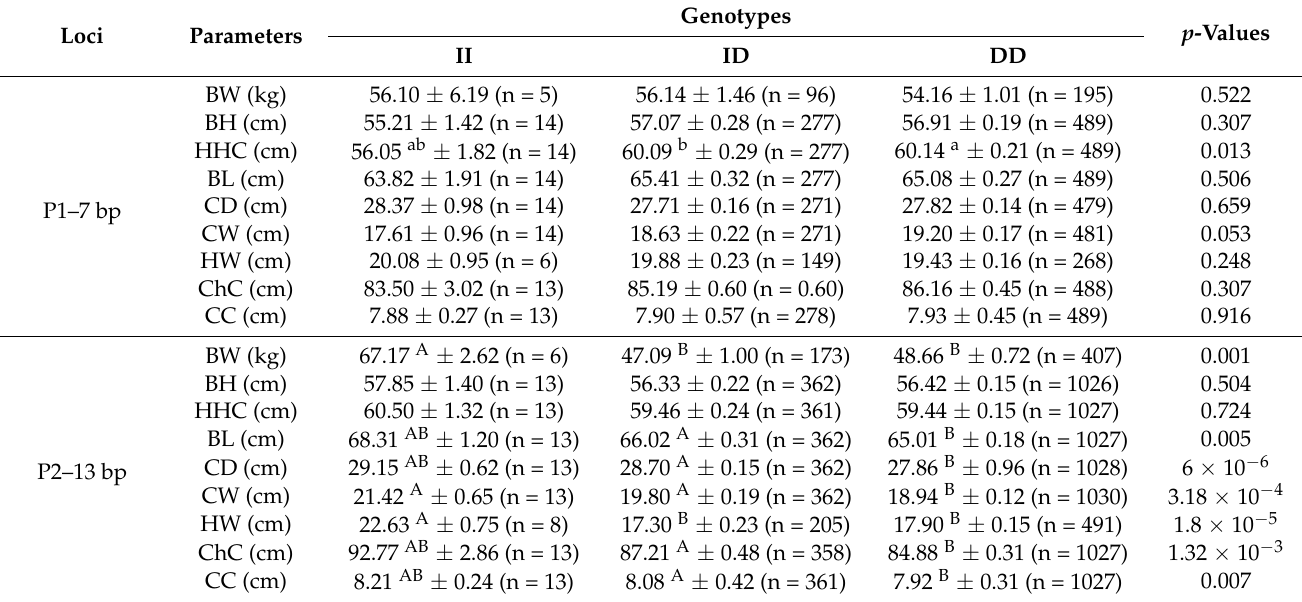
Table 3. Associations of two indel loci within AKAP12 gene growth parameters in Shaanbei white cashmere (SBWC) goats (mean ± SE).